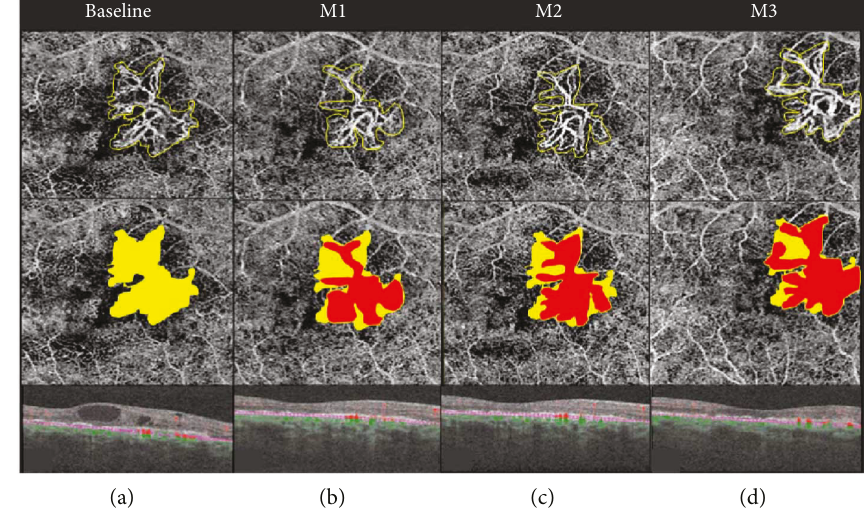
Figure 1: OCTA follow-up of treatment-naïve choroidal neovascularization (CNV) associated to neovascular age-related macular degeneration (AMD) during the monthly loading anti-VEGF phase. Each column represents a visit; the upper row represents the quanti fi cation of CNV size on the outer retina to choriocapillaris (ORCC) slab; the lower row represents the comparison between baseline lesion area (yellow) and follow-up CNV area (red). Quantitative analysis demonstrated that at baseline, the area in the ORCC segmentation averaged 1.06 mm 2 . Under anti-VEGF therapy, this area decreased signi fi cantly, to 0.55mm 2 , at month 1 (M1). At month 2 (M2), the area averaged 0.72mm 2 , while at month 3 (M3), at the end of the loading phase, the CNV area was 0.87mm 2 . Indeed, the CNV area decreased from baseline to month 3 by 17.39%. This decrease has been noticed on the overall cohort of treatment-naïve in a statistically signi fi cant manner ( P = 0 02 , Figure